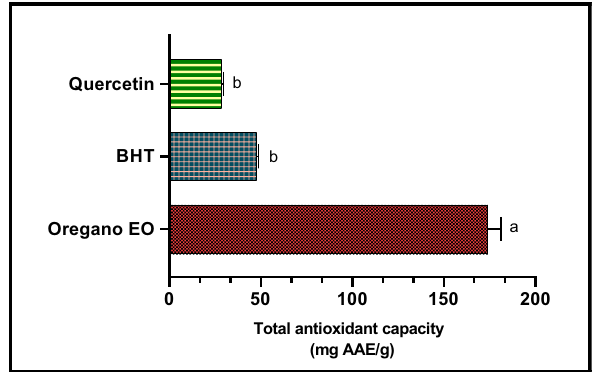
Figure 4: Total antioxidant capacity of O. compactum EO, BHT, and Quercetin. Bars with di ff erent letters are signi fi cantly di ff erent at p < 0.05.